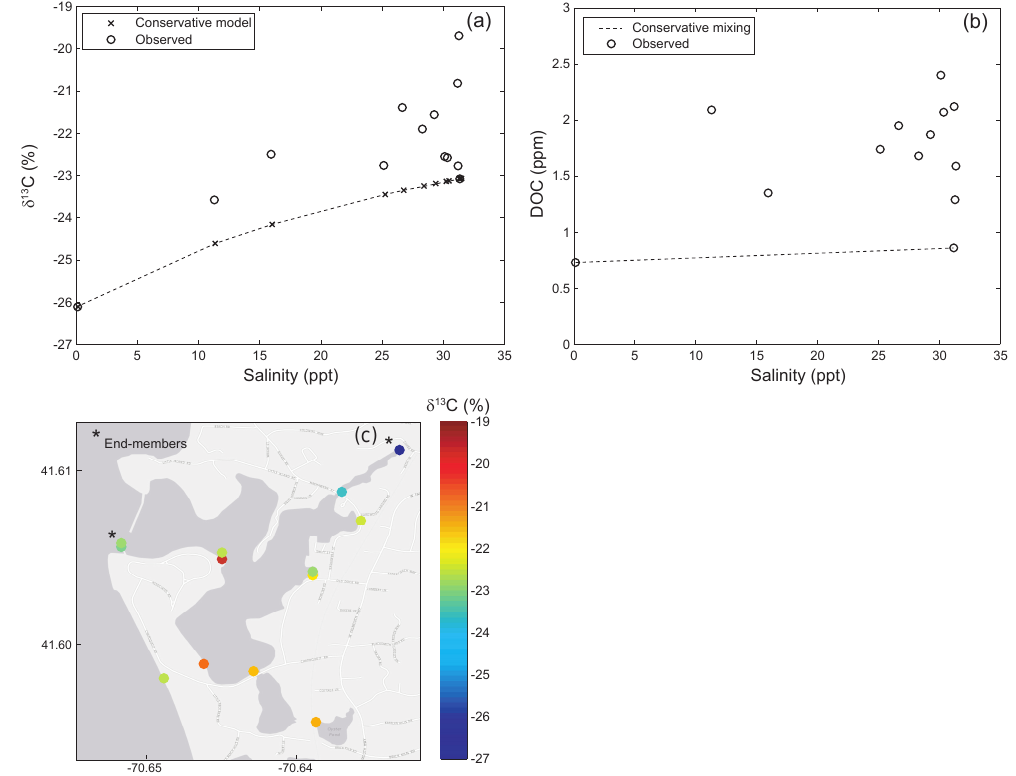
Figure 4. (a) Measured δ 13 C-DOC values and salinity for West Falmouth Harbor are plotted against an isotopic conservative mixing model for location. Deviations from the model suggest contributions of DOC 13 C-enriched relative to the assumed end-members. (b) Measured DOC concentration and salinity for West Falmouth Harbor are plotted along with a line of concentration-based conservative mixing between end-members. Data points with concentrations greater than those predicted by conservative mixing indicate addition of DOM to the system. (c) Spatial plot of isotopic signatures measured at West Falmouth Harbor. Asterisks indicate assumed